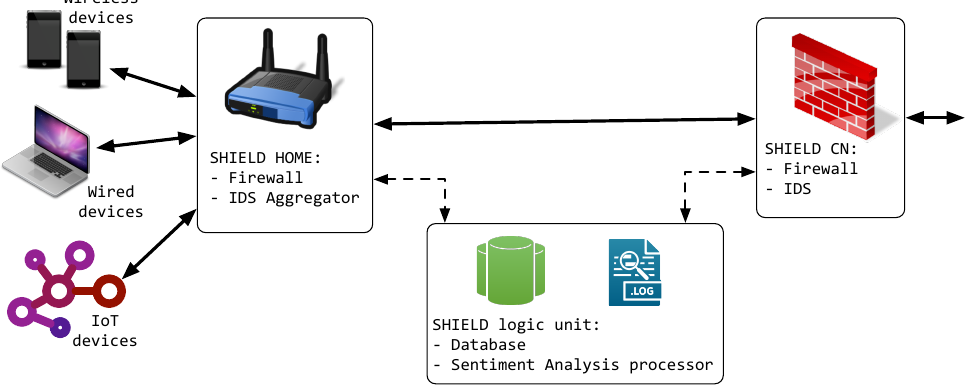
Figure 1. SHIELD